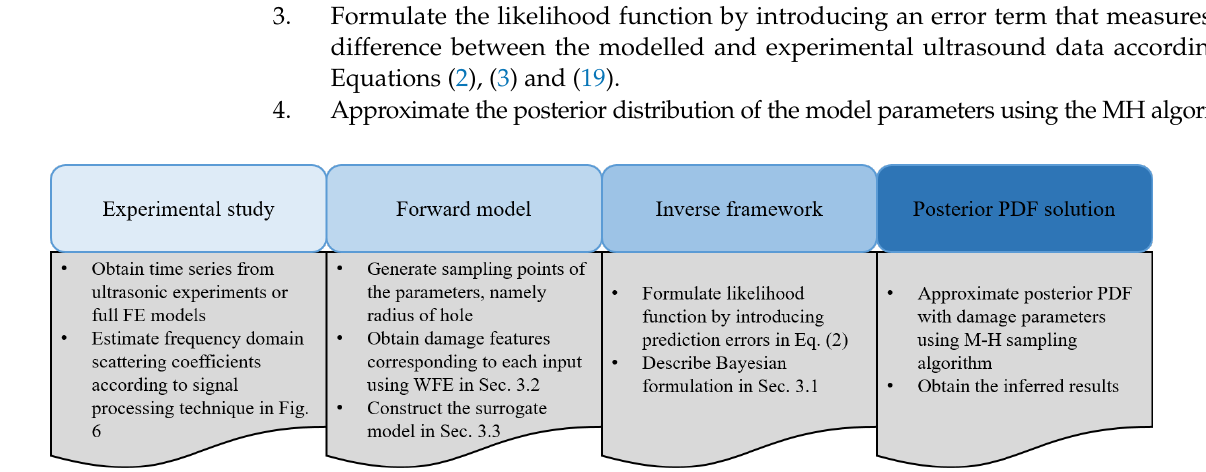
Figure 8. Workflow of Bayesian inference for damage identification with scattering coefficients obtained from the WFE − assisted surrogate model.